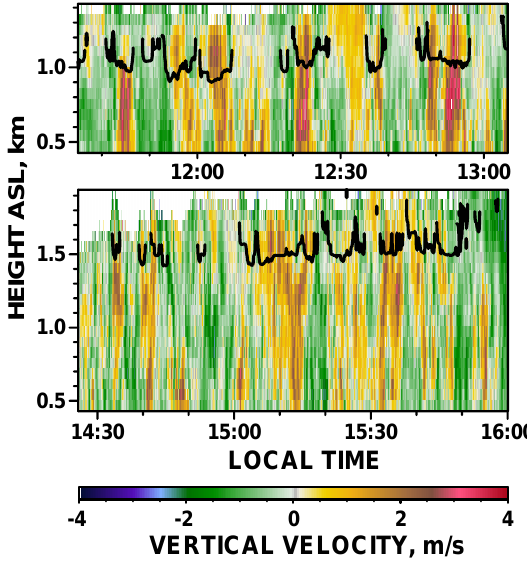
Fig. 11. Updraft and (negative) downdraft vertival velocity w up and − w do normalized to the convection velocity scale w ∗ versus draft width normalized to the ABL top height z i . Curves (polynomial functions) are fitted to the observed data. Fit parameters are given in Table 3. Table 3. Fit parameters ( ± standard deviation) describing the line curves in Fig. 11. The function is w D /w ∗ = A + B 1 (d/z i ) +